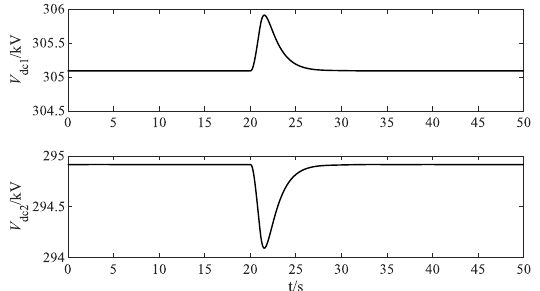
Figure 13. DC voltage variation of proposed control under short circuit fault.